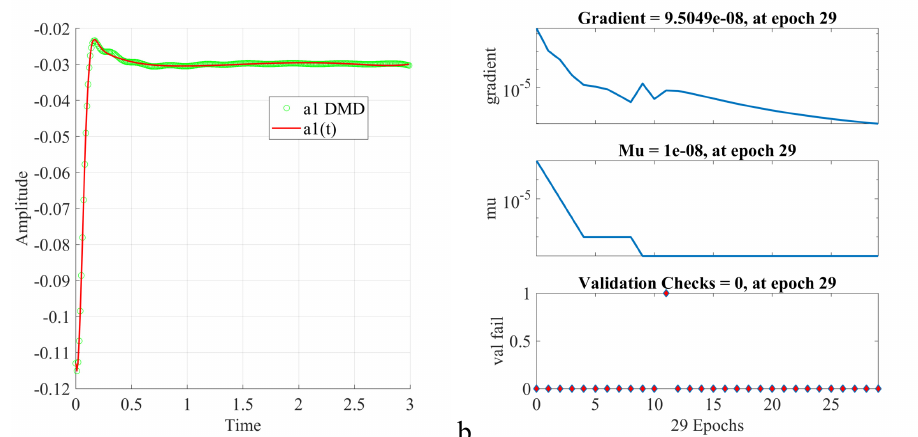
Figure 14. ( a , b ) The validation for the first temporal coefficient, as simulated response of the optimal NLARX estimator, in the case of experiment Re = 10 2 .